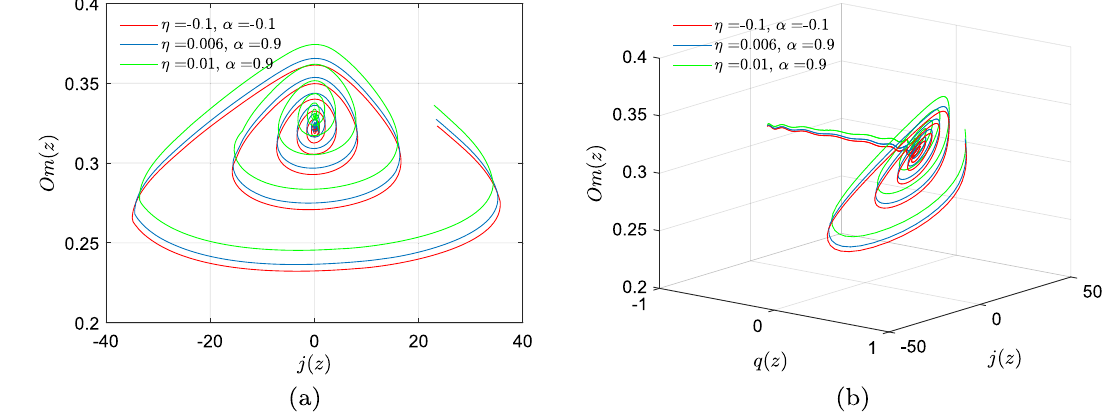
Fig. 14 a Comparison of model I with Union 2.1 supernova data while the model parameters chosen at η = 0 . 006, α = 0 . 9. b χ 2 representation of model I in η − α parameter plane using Union 2.1 supernova data. In this plot the while dashed line corresponds to the case of η = 0